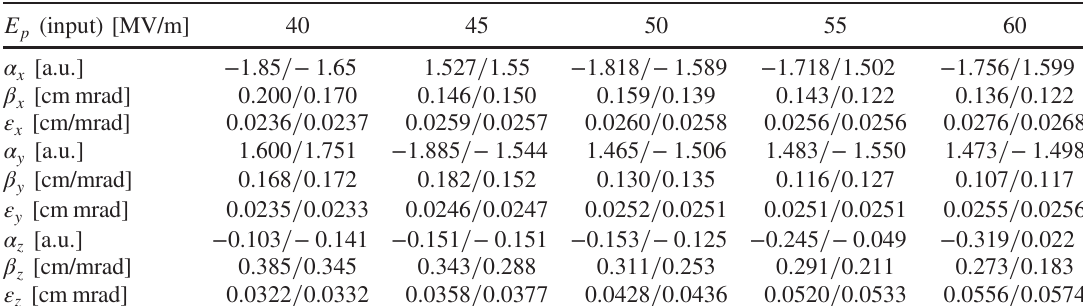
TABLE IX. Twiss parameters and RMS emittance at RFQ entrance position determined with RFQGen software. Each cell contains a data represented as A/B. A denote the obtained result for proton 2.5 MeV simulation, and B denote the obtained result for proton 5 MeV simulation.